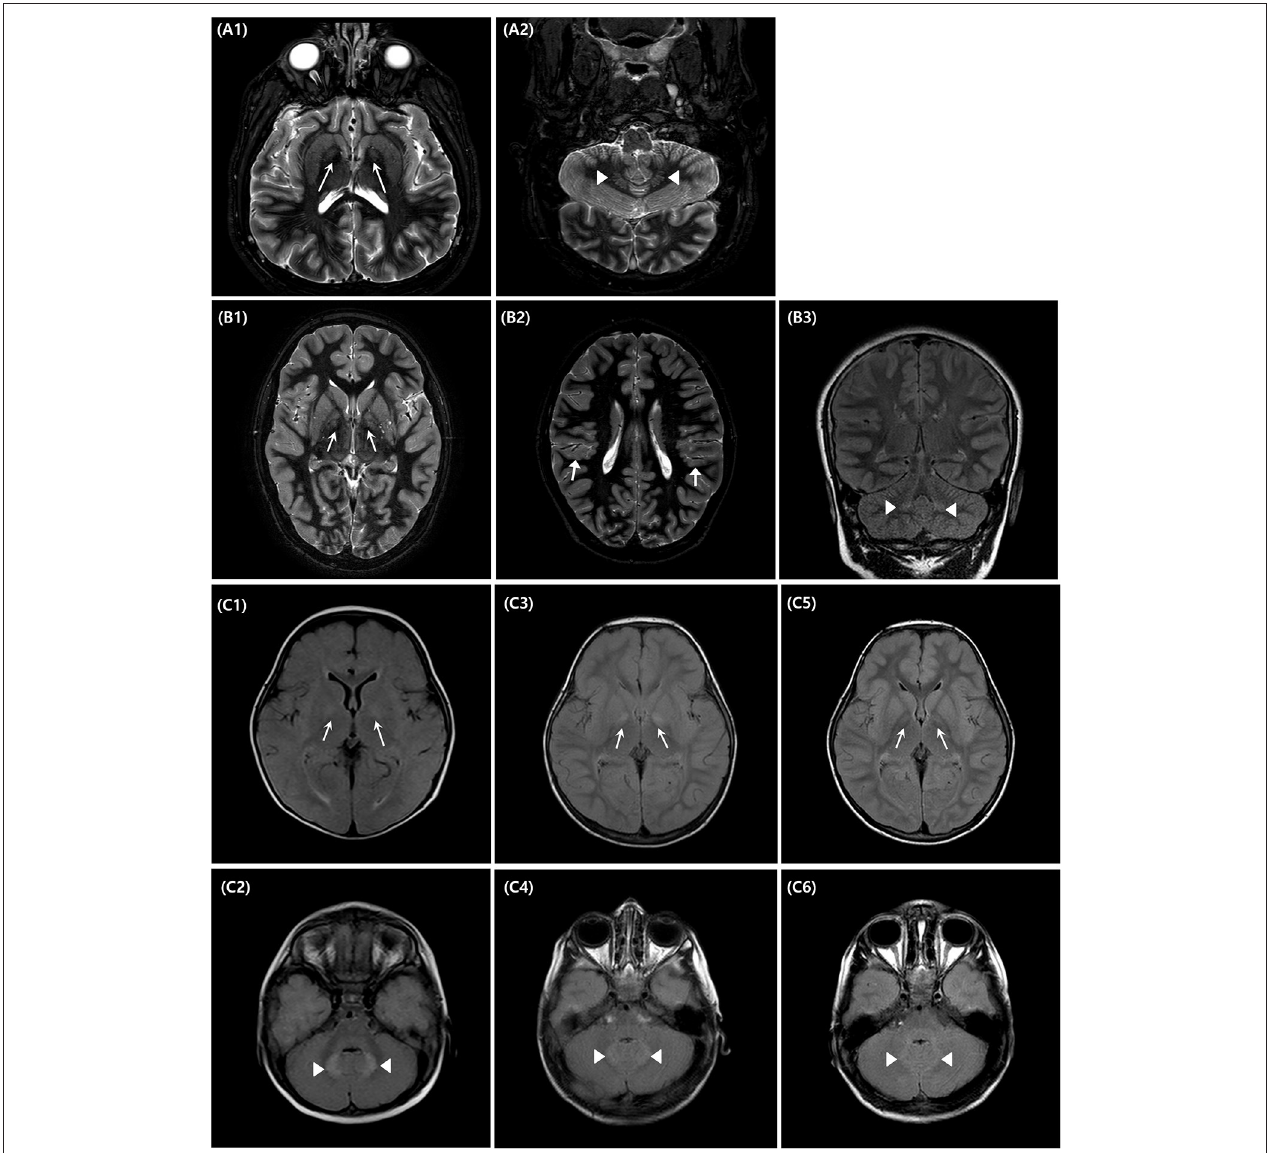
FIGURE 3 | Brain magnetic resonance imaging of the affected individuals (IV-1, 4, 6). Three affected patients underwent brain magnetic resonance imaging (MRI) at different ages [ (A) –Patient 1, (B) –Patient 2, (C) –Patient 3]. Patient 1 showed increased signal changes in the bilateral globus pallidi (A1) and the cerebellar dentate nuclei (A2) on T2-weighted axial images obtained at the ages of 22 years old. Patient 2 underwent brain MRI at the ages of 10 (B1–B3) . There are bilateral high signal intensity lesions in the same area as patient 1, on T2-weighted axial and fluid-attenuated inversion recovery coronal images, and additionally, bilateral polymicrogyria around the perisylvian area are seen [ (B2) , arrow marks]. Patient 3 underwent a series of three brain MRIs when 8 months (C1,C2) , 2 years (C3,C4) , and 4 years old (C5,C6) , respectively. Brain MRI performed at 2 years of age, showed the most distinct high signal intensity of bilateral globus pallidi (C3) and cerebellar dentate nuclei (C4)